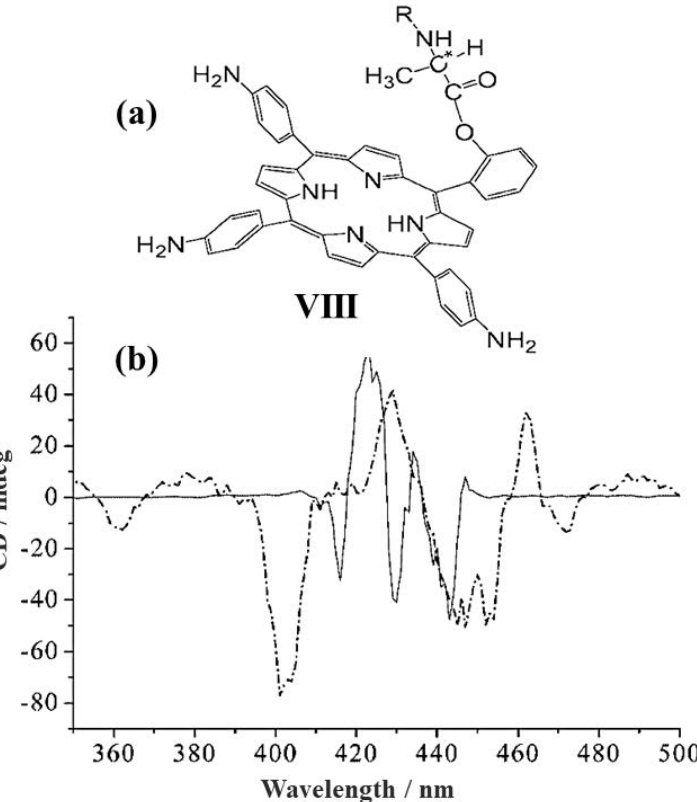
Figure 5. ( a ) Structure of the chiral porphyrin VIII (R = Boc); ( b ) CD spectra of the chiral porphyrin VIII in chloroform (solid line), SBA-15/porphyrin in solid-state (dash-dotted line). Adapted with permission from reference [63]; published by John Wiley and Sons 2006.